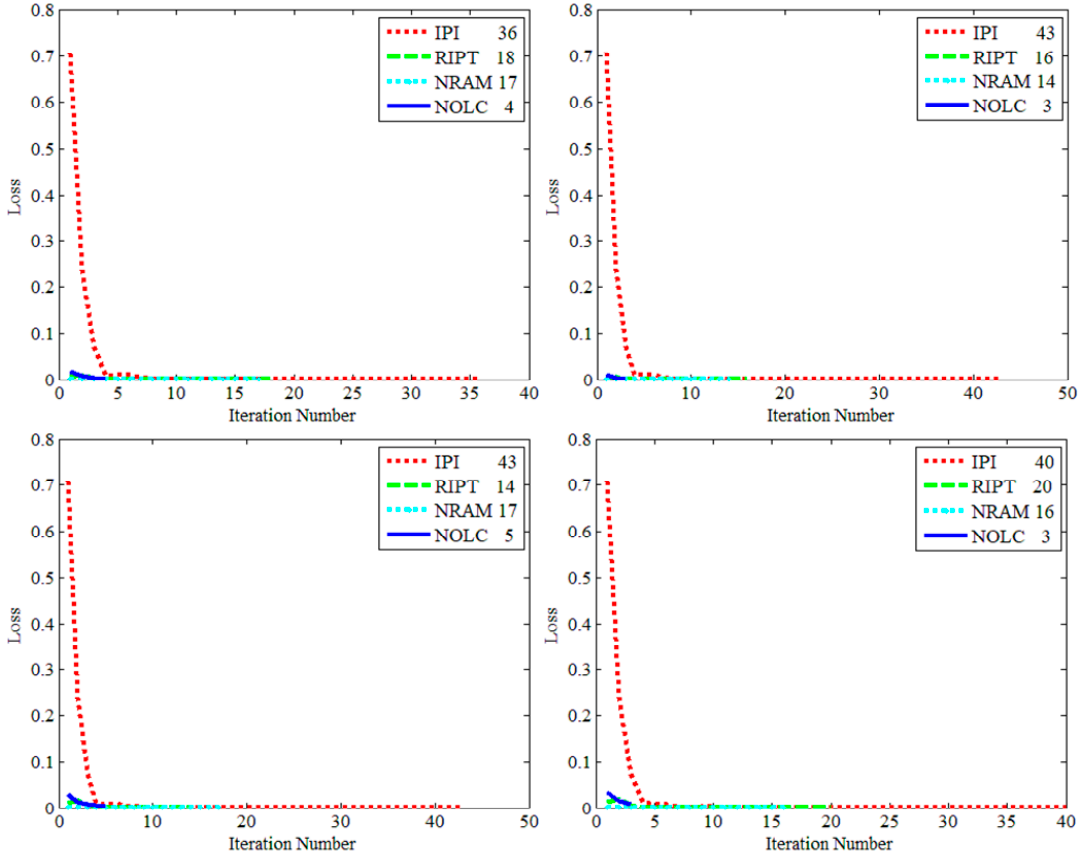
Figure 19. Iteration number comparison.